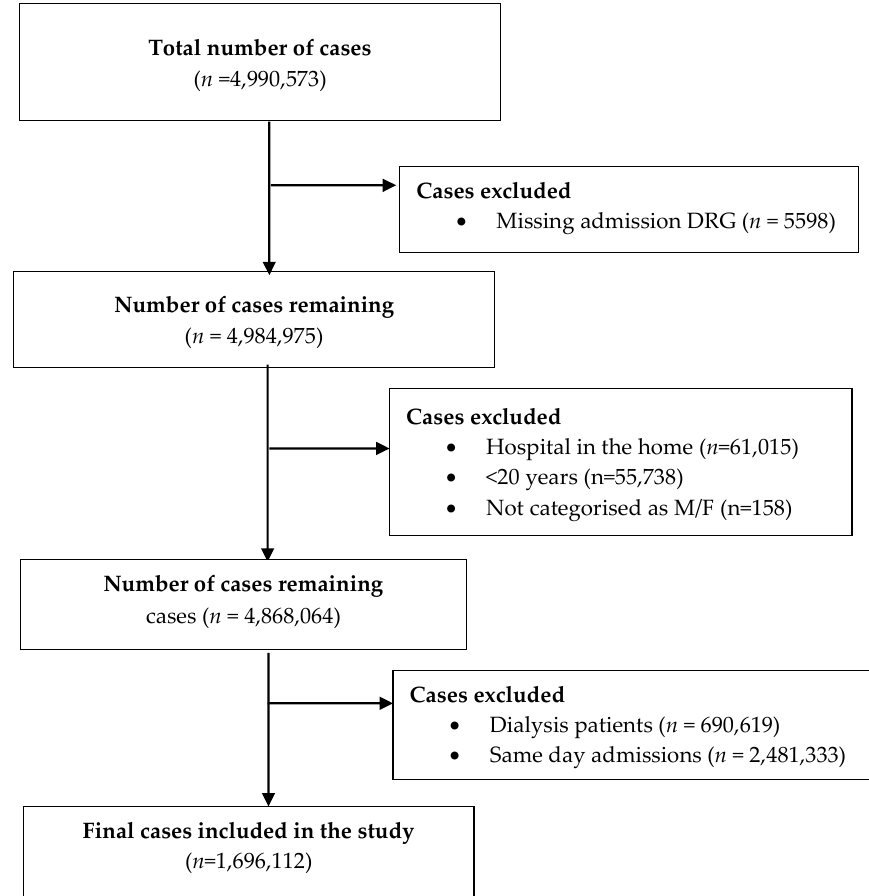
Figure 1. Details of multi-stay admissions included in the study following exclusion of admissions with missing data, same-day admissions, admissions associated with hospital in the home care, and patients less than 20 years. DRG = diagnostic related group, M = male, F = female. Table 1. Characteristics of patients hospitalized over two years in Victoria, Australia.